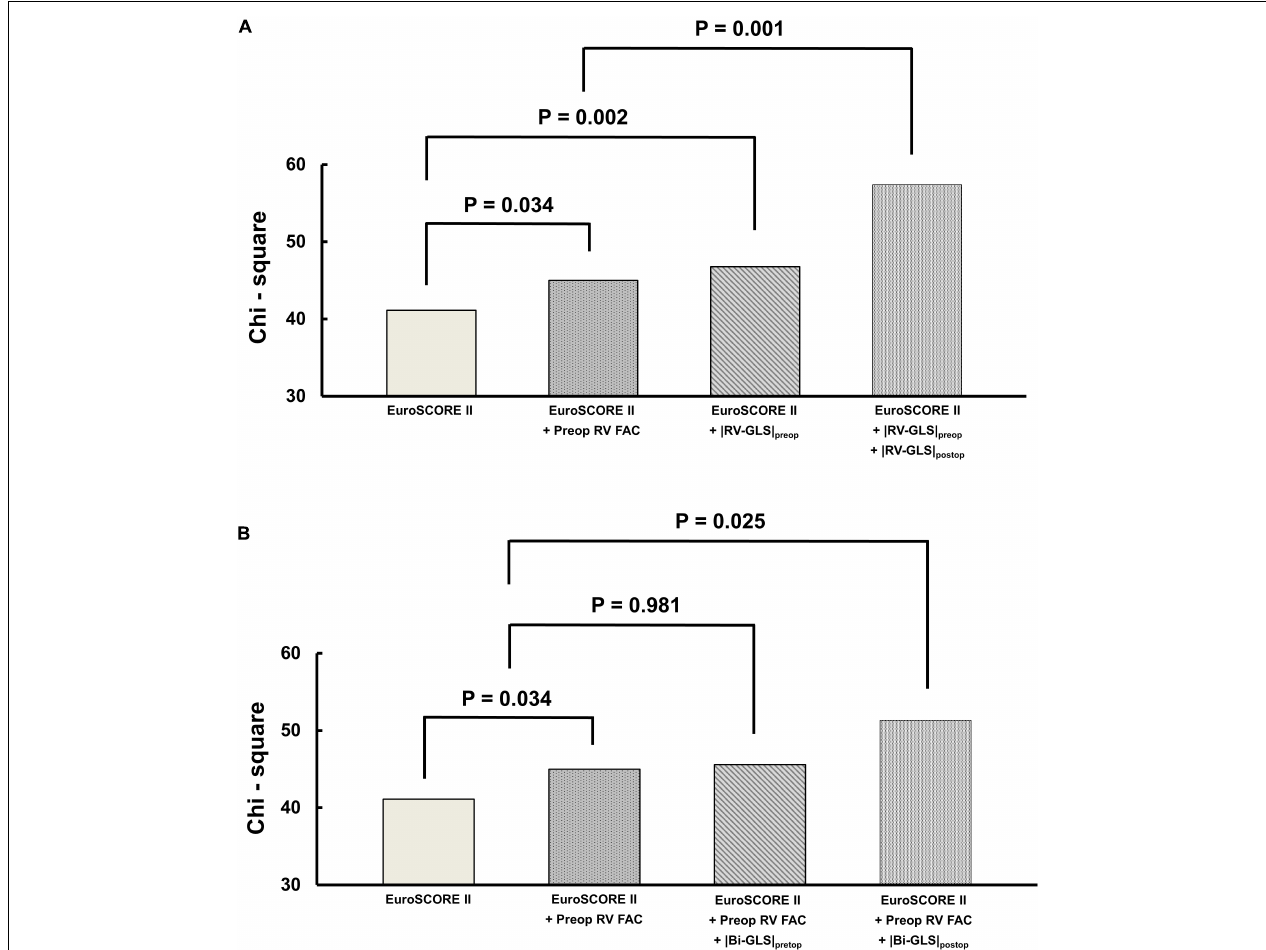
FIGURE 5 | Incremental prognostic value of preoperative and postoperative (A) |RV-GLS| and (B) biventricular |GLS| over EuroSCORE II. RV, right ventricle; FAC, fractional area change; |GLS|, absolute value of global longitudinal